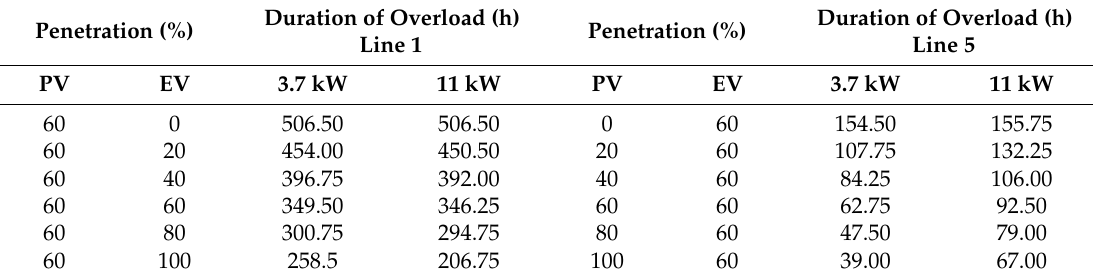
Table 2. Duration of overloads (utilisation > 100%) for the lines 1 and 5 – charging power 3.7 kW and 11 kW, using charging strategy